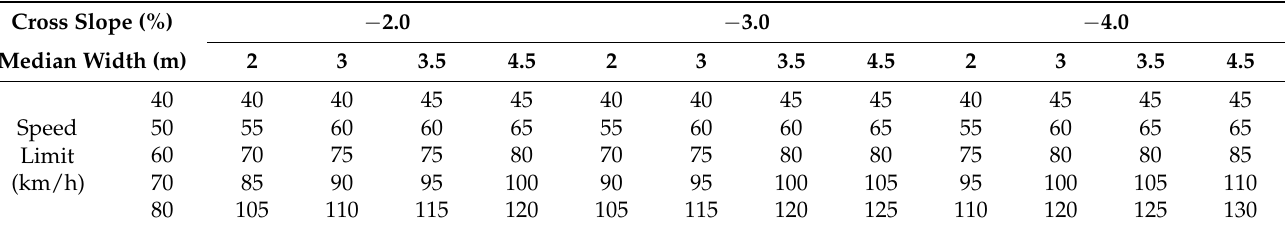
Table 2. Calculated values of the median opening length under different cross slopes, median widths and speed limits